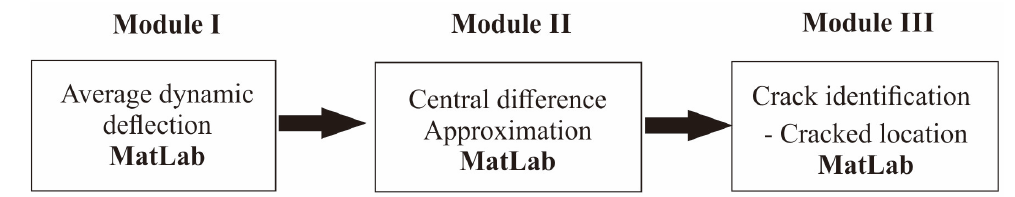
Figure 1. Flow diagram of the operations.